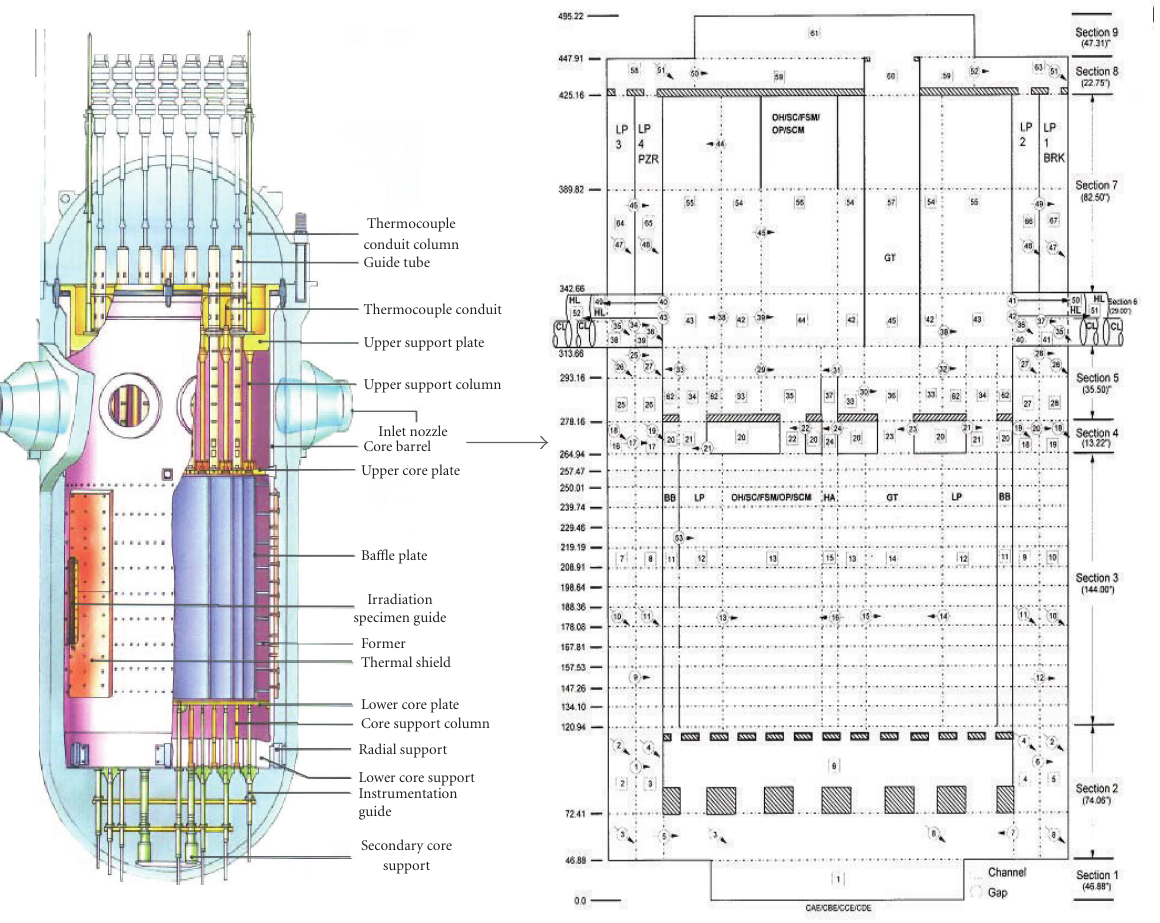
Figure 3: WCOBRA/TRAC typical noding of the reactor